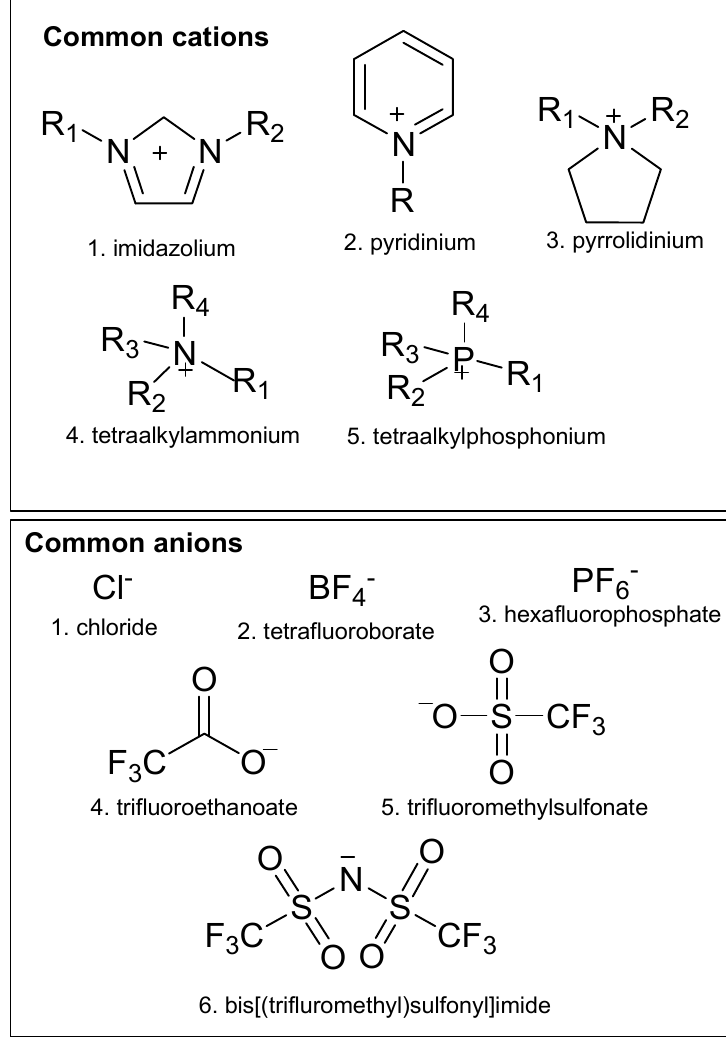
Figure 1. Structures of common cations and anions of ionic liquids.